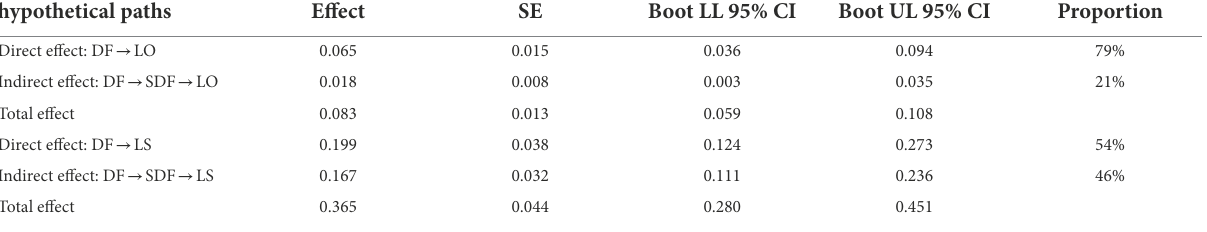
TABLE 7 Results of mediation effect test.